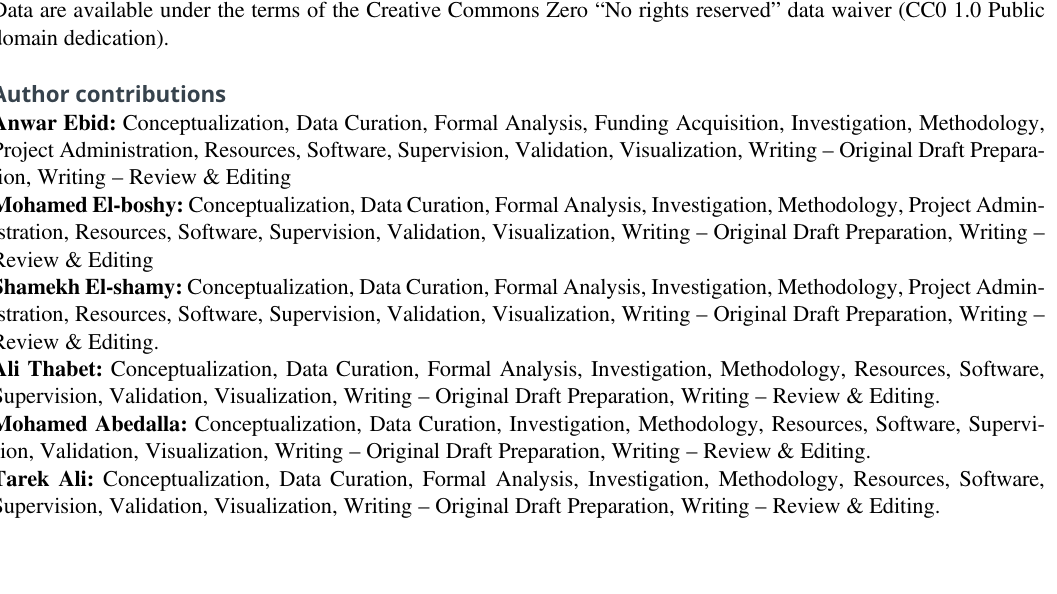
Figshare: Extended data for ‘ Long-term effect of full-body pulsed electromagnetic field and exercise protocol in the treatment of men with osteopenia or osteoporosis: A randomized placebo-controlled trial ’ . The project contains the following underlying